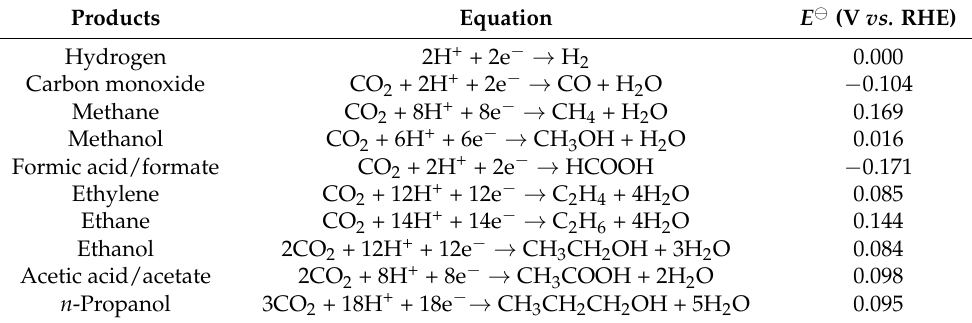
Figure 2. Schematic of electroreduction of CO 2 in the H-cell. Table 1. Electrochemical potentials of possible CO 2 RRs in aqueous solutions [43].